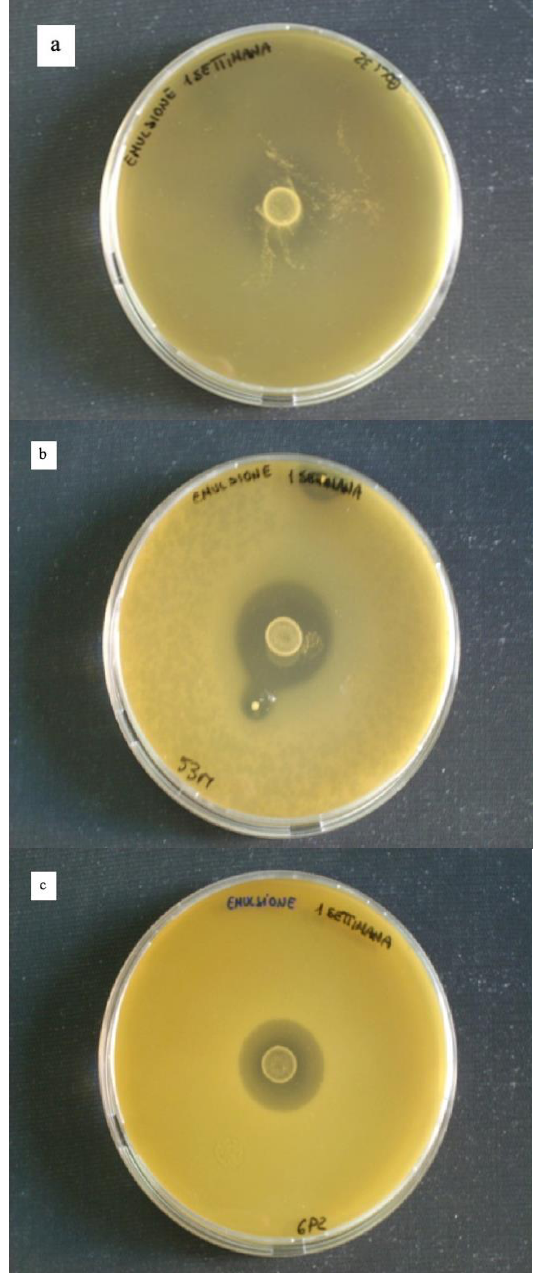
Figure 5. Antimicrobial activity of 1 week old L. reuteri DSM 17938 microencapsules against E. coli 32 (panel a ), H. alvei 53M (panel b ) and P. fragi 6P2 (panel c ).